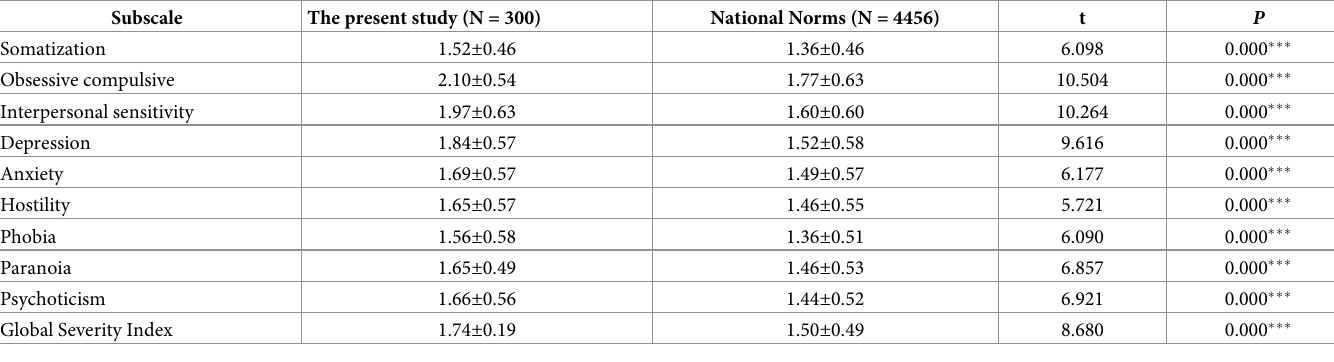
Table 2. Comparison of SCL-90 subscale scores between study participants and nationwide norms of college students (x ± s). Subscale